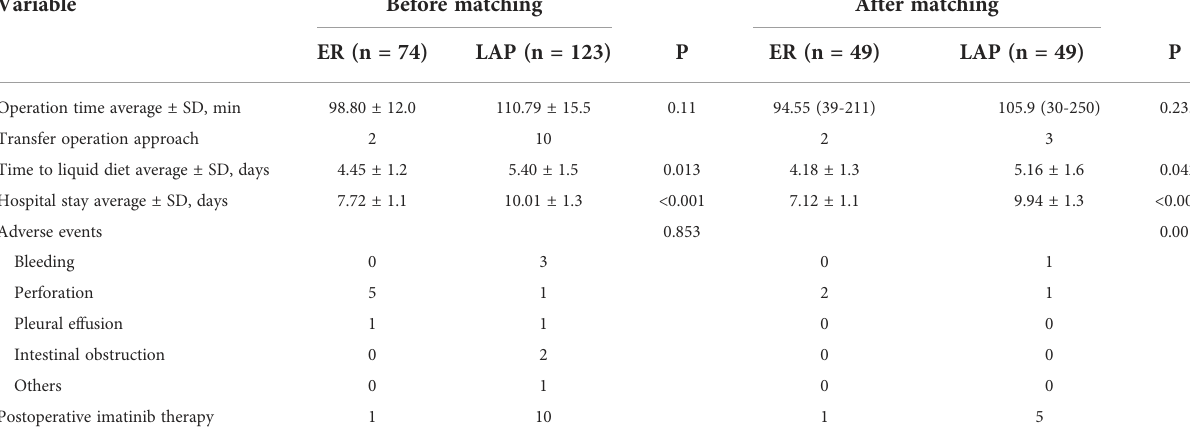
TABLE 2 Therapeutic outcomes of included patients. Variable Before